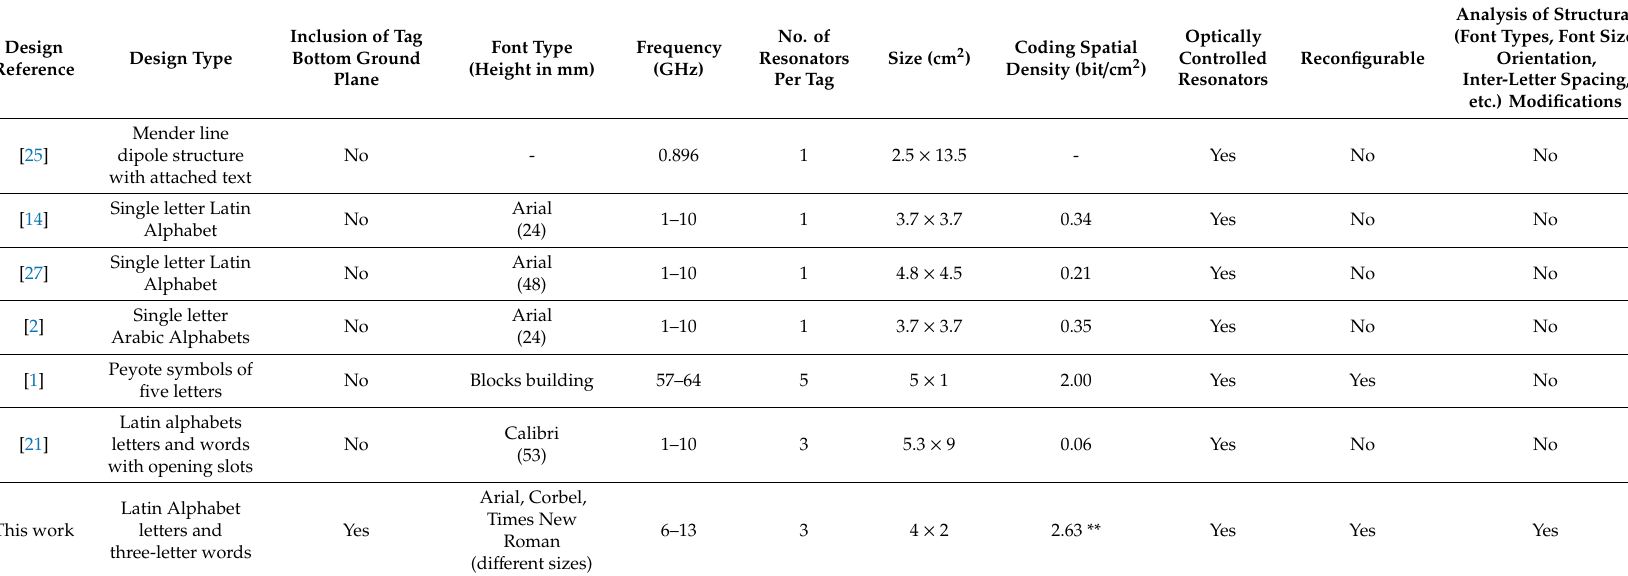
Table 4. Comparison of proposed design and robust coding technique with RFID chipless printable alphabets legacy